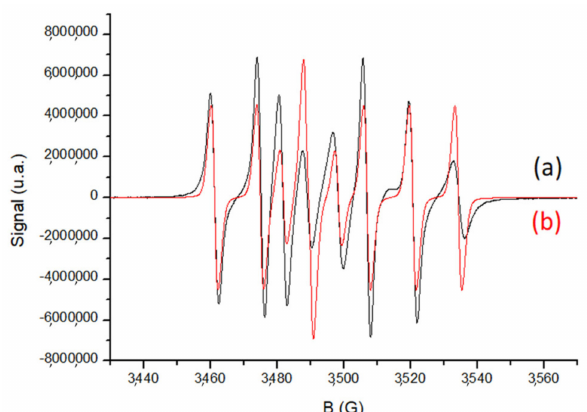
Figure 11. ESR-spin trapping spectrum of Napht in combination with Blocbuilder ® MA Ar 2 I + PF 6 − and 4-dppba in Mix-MA; under air after 15 s of irradiation with an LED@405 nm (110 mW cm − 2 ) exposure: ( a ) Experimental; ( b ) Simulation of the ESR-spin trapping spectrum of 75% of SG1 radicals ( a N = 13.7 g; a P = 45.7 g) and 25% of ROO • ( a H = 8.2 G; G = 2.011).